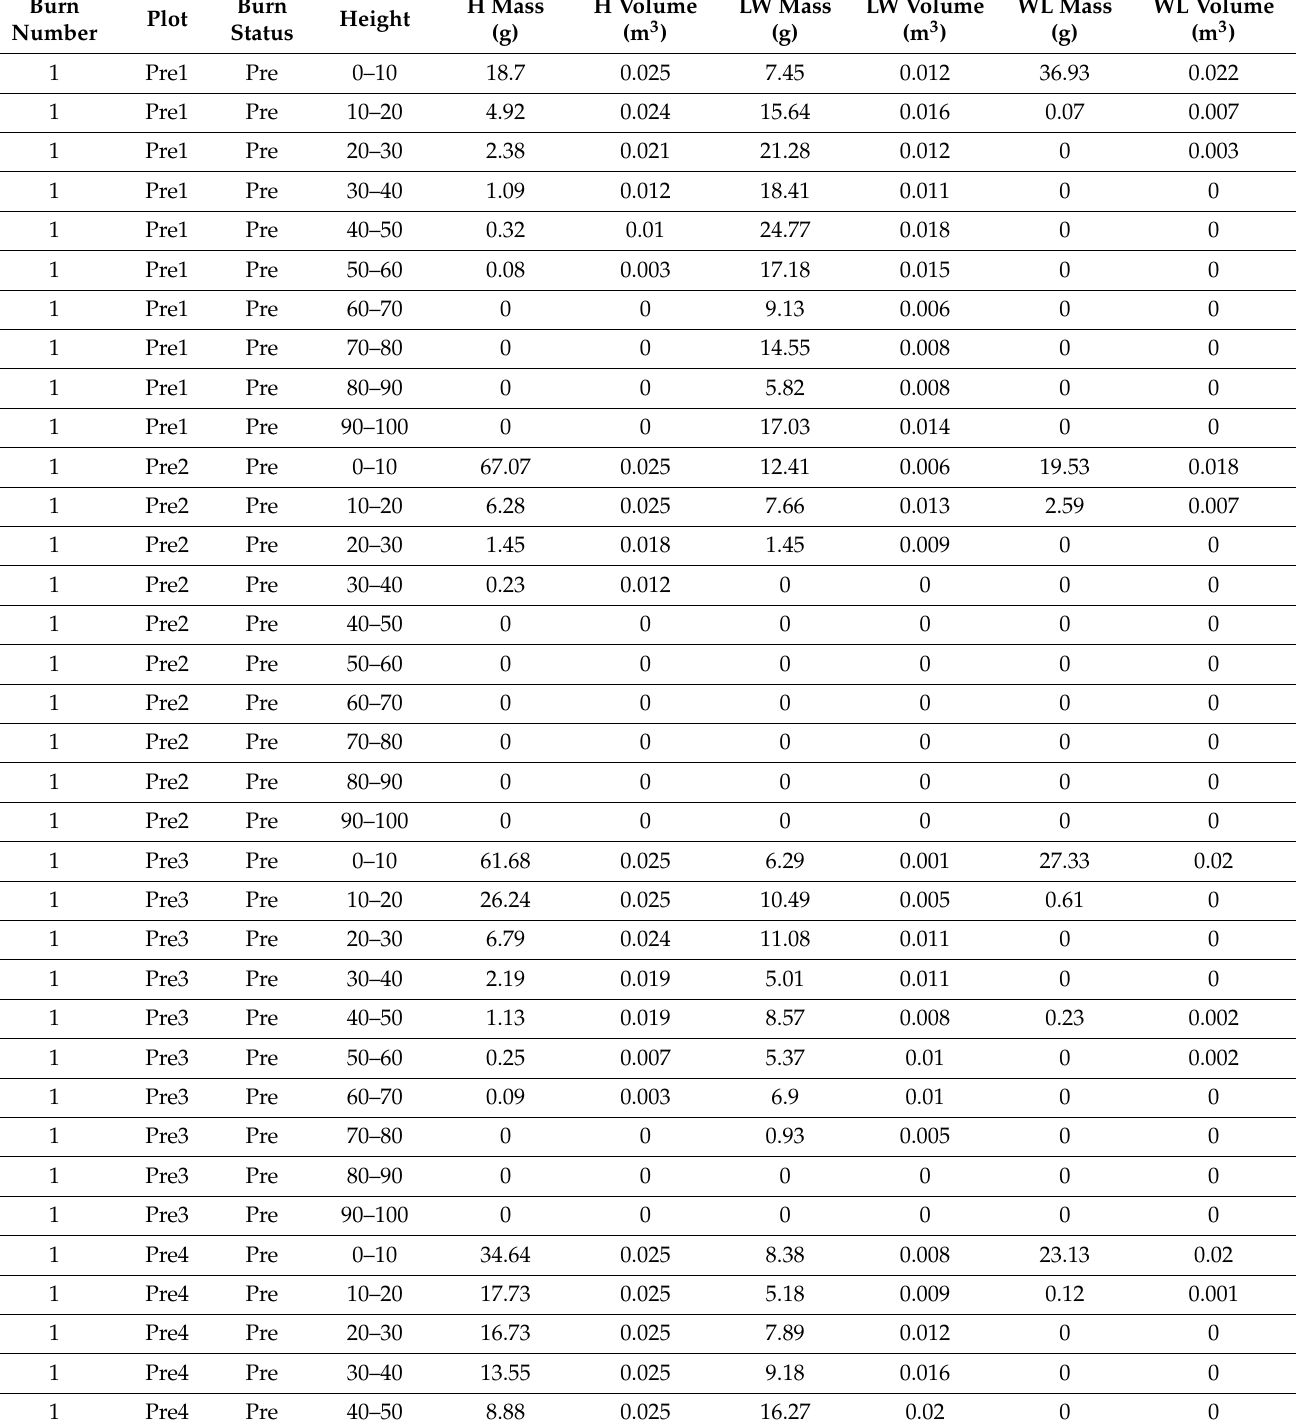
Table A1. Data used in this study. Burn Number represents which arbitrary burn unit was sampled while Plot represents an individual clip plot in each burn unit. The “Pre” preceding the plot number indicates a Preburn plot while “Post” preceding the plot number represents a Postburn plot. The number in Plot represents paired plots. For example, within the same Burn Number, Pre2 and Post2 are paired plots. Burn Status describes when the data was taken, where Pre = before burn and Post = after burn. Therefore, Mass and Volume were collected before the burn for every preburn plot. While mass was only recorded after the burn for postburn plots, volume was recorded both before and after the burn. Height describes at which height stratum the data was collected. For Mass and Volume, H = Herbaceous, LW = Live Woody, and WL = Woody Litter. Further descriptions of the methodology are in the main